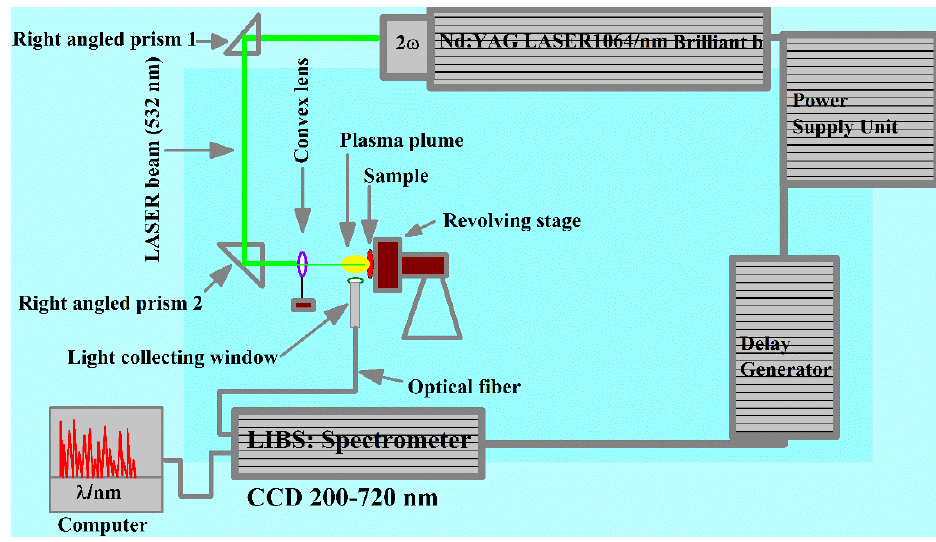
Figure 1. Experimental LIBS setup used to study the laser-generated plasma of the AlGaAs sample.